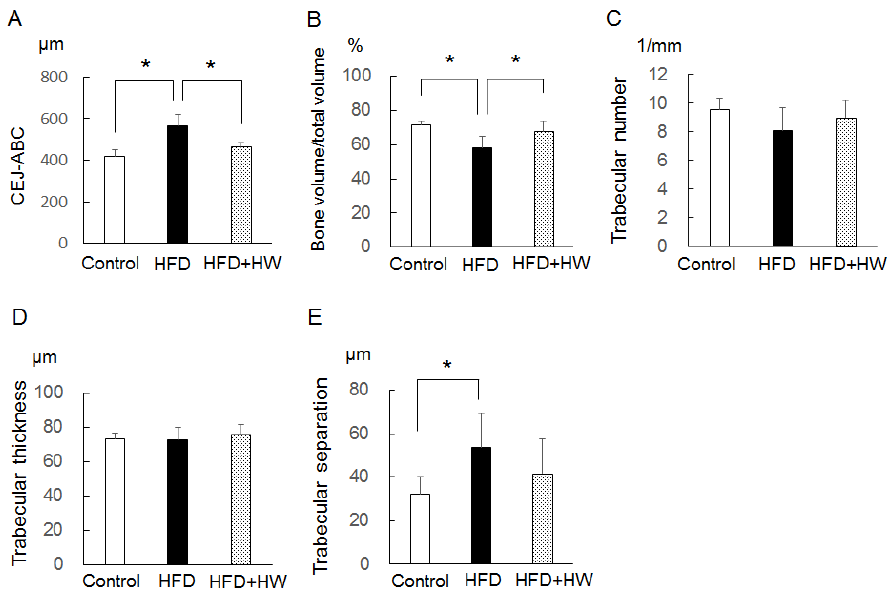
Figure 3. Bone morphogenetic analyses of rat mandible at 20 weeks old. ( A ) Distance between CEJ ‐ ABC; ( B ) percentage of bone volume/total volume; ( C ) trabecular number; ( D ) trabecular thickness; ( E ) trabecular separation. Values are presented as the mean ± standard deviation of six rats. * p < 0.05, using Tukey’s methods.